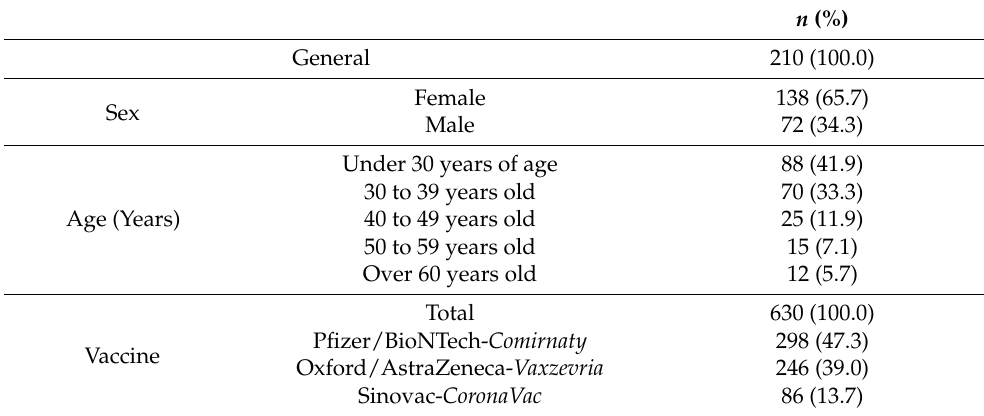
Table 1. Sociodemographic characteristics and vaccine that was administered to the participants.